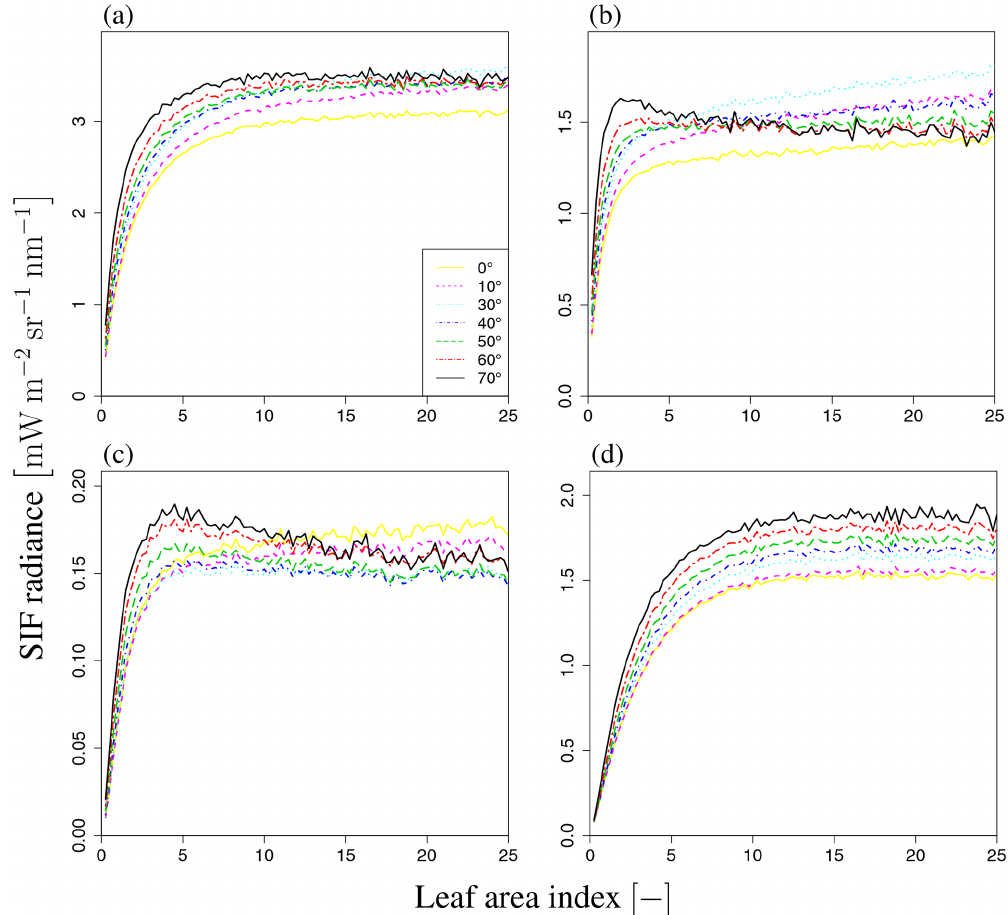
Figure 14. LAI dependency on SIF radiance. (a) Total radiance I , (b) direct radiance from sunlit leaves I dir_sun , (c) direct radiance from shaded leaves I dir_shade , and (d) radiance after multiple scatterings I ms_sun + I ms_shade at SZA of 20 ◦ and SAA of 0 ◦ (forward direction). Each line represents a different VZA value (0–70 ◦ ). SIF radiance increases with LAI and then becomes saturated in most cases. However, when VZA is large (e.g., black and red lines), the direct radiance decreases with an increase in